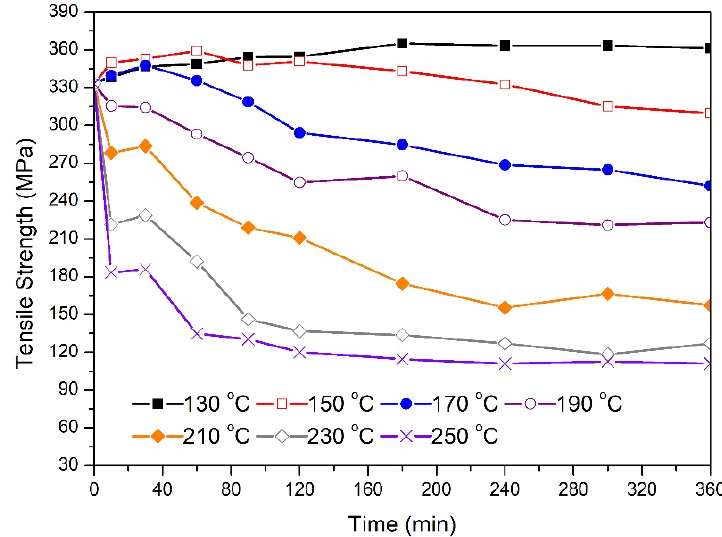
Figure 3. Changes in tensile strength as a function of the annealing time for 3.5 mm samples at the specified temperature.